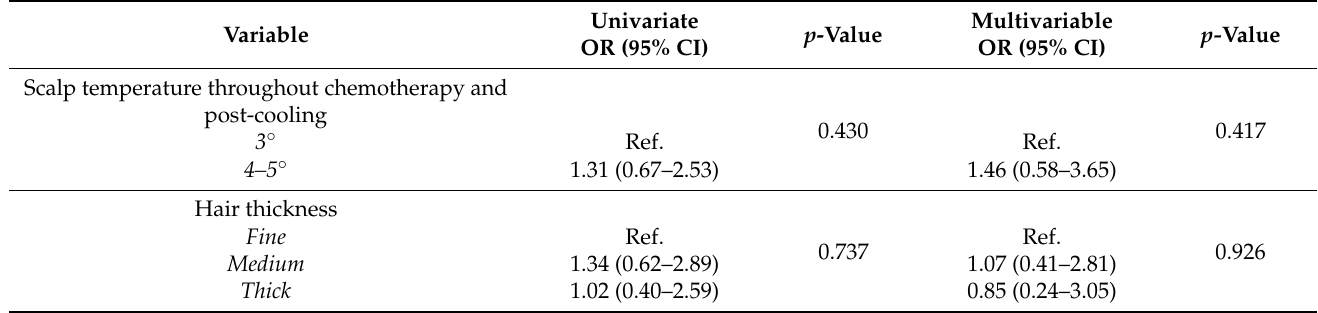
Table 4. The univariate and multivariate logistic regression analysis of hair loss degree, evaluated by medical staff after the completion of all cycles of chemotherapy, according to the patient and treatment